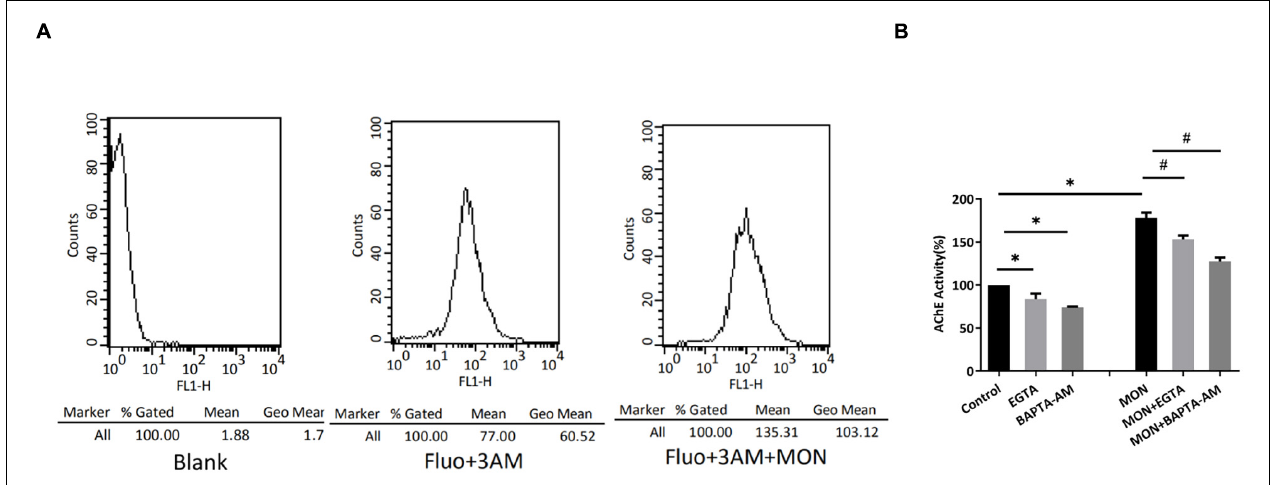
FIGURE 7 | Monensin stimulates exosome release by a calcium-dependent mechanism. (A) Podocytes were loaded with Fluo-3AM, and intracellular Ca 2 + concentration was measured. Shown are changes in Ca 2 + concentration elicited by 7 µ M MON. Data are representative of at least three independent experiments. (B) Podocytes were incubated for 7 h in the presence of 1.5 mM EGTA, 30 µ M BAPTA-AM, 7 µ M MON, or the combination of 1.5 mM EGTA/7 µ M MON (MON + EGTA) or 30 µ M BAPTA-AM/7 µ M MON (MON + BAPTA-AM). The secreted exosomes were collected and quantitated by measuring the AChE activity. ∗ significantly different from the control, P < 0.05. # significantly different from the MON-treated cells, P <